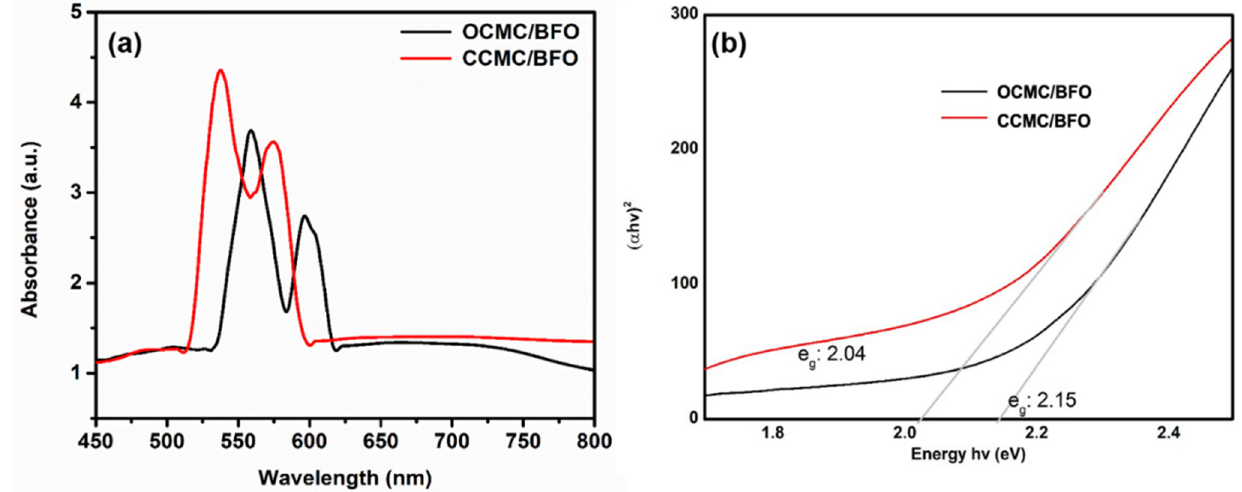
Figure 8. ( a ) UV ‐ Vis spectra and ( b ) Band gap of CCMC/BFO and OCMC/BFO composite films.